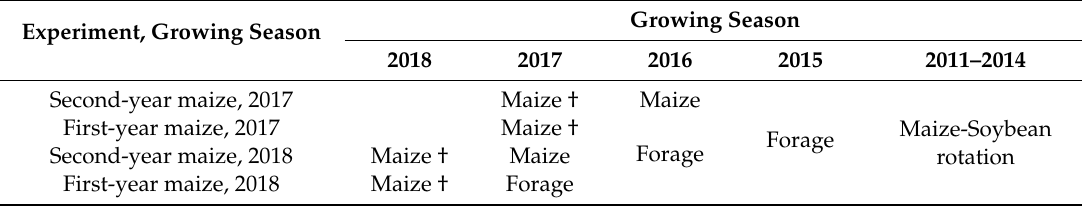
Table 1. Crop rotations for first- and second-year maize